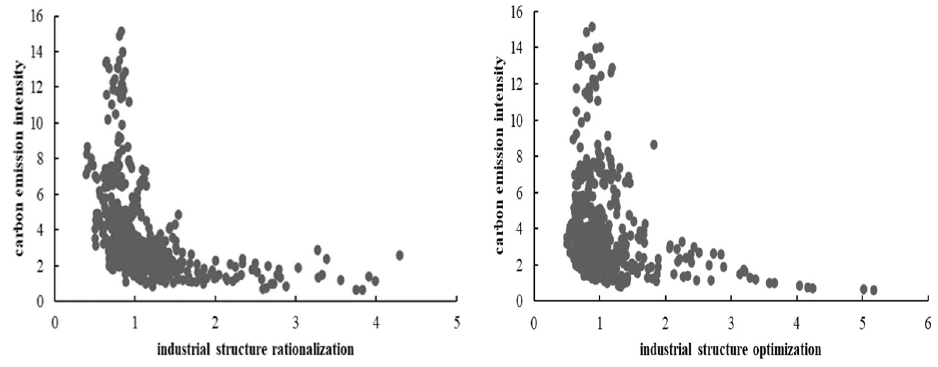
Figure 4. Linear fitting of industrial structure rationalization, industrial structure optimization, and carbon emission intensity.